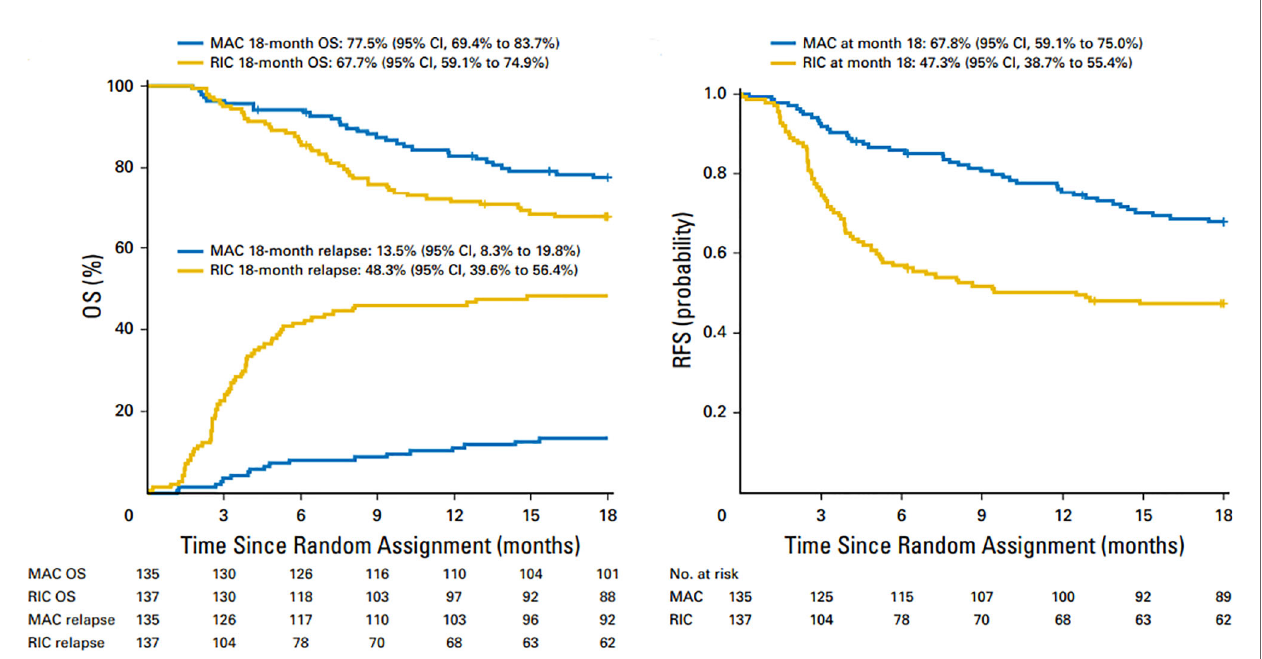
FIGURE 1 | Overall survival and relapse-free survival after 18 months in patients treated with MAC and RIC regimens. Similar OS and higher relapse rates in RIC vs MAC regimens (left panel) and superior RFS with MAC regimens (right